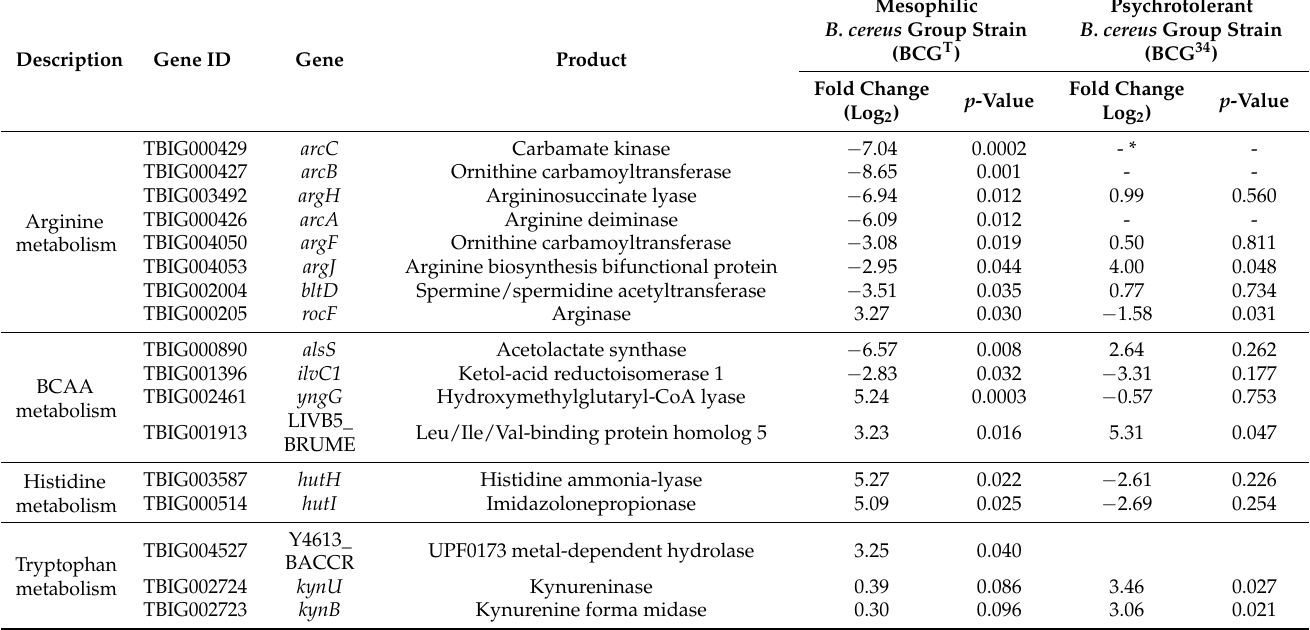
Table 5. Differential gene expression related to amino acid metabolism of mesophilic B. cereus group strain (BCG T ) and psychrotolerant B. cereus group strain (BCG 34 ) grown at 10 ◦ C compared to growth at 30 ◦